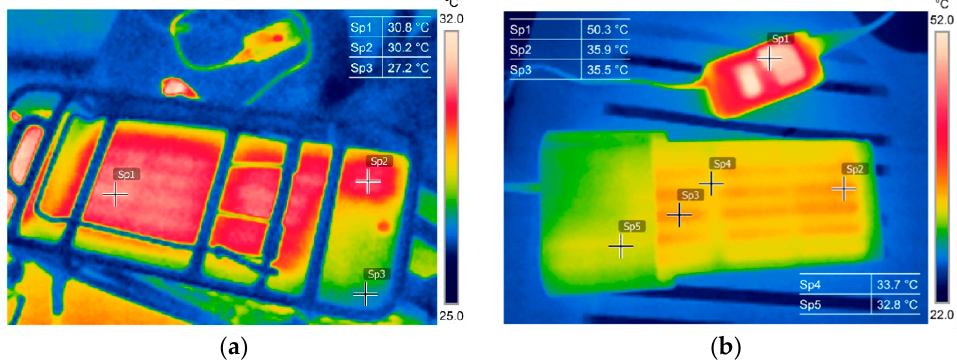
Figure 6. Functional battery pack charging thermal patterns near the end of its life, ( a ) top view ( b ) bottom.